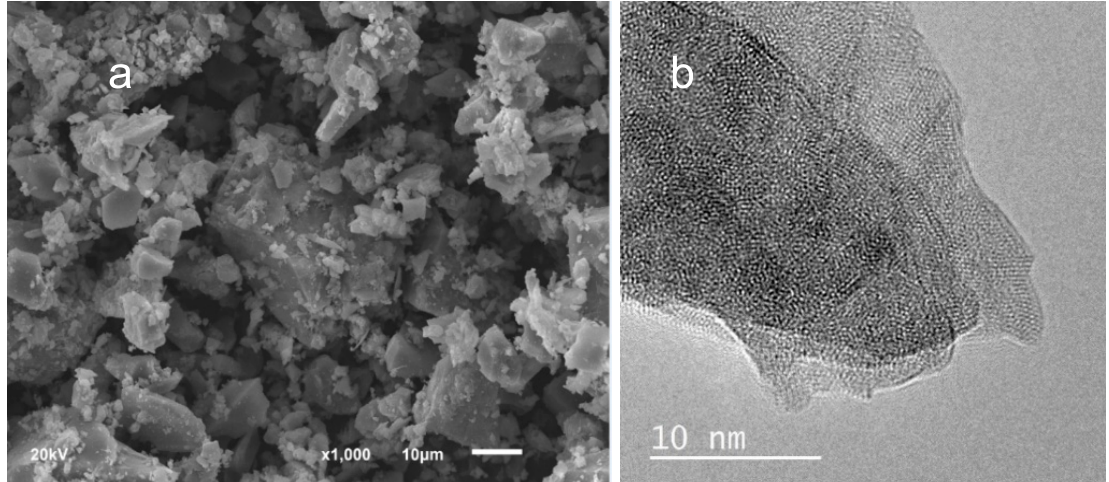
Figure 2. SEM and TEM images showing the morphology ( a ) and nano-domains ( b ) of schwertmannite particles obtained by aging after 28 days of aging (LC-28). Minerals 2019 , 9 , x FOR PEER REVIEW